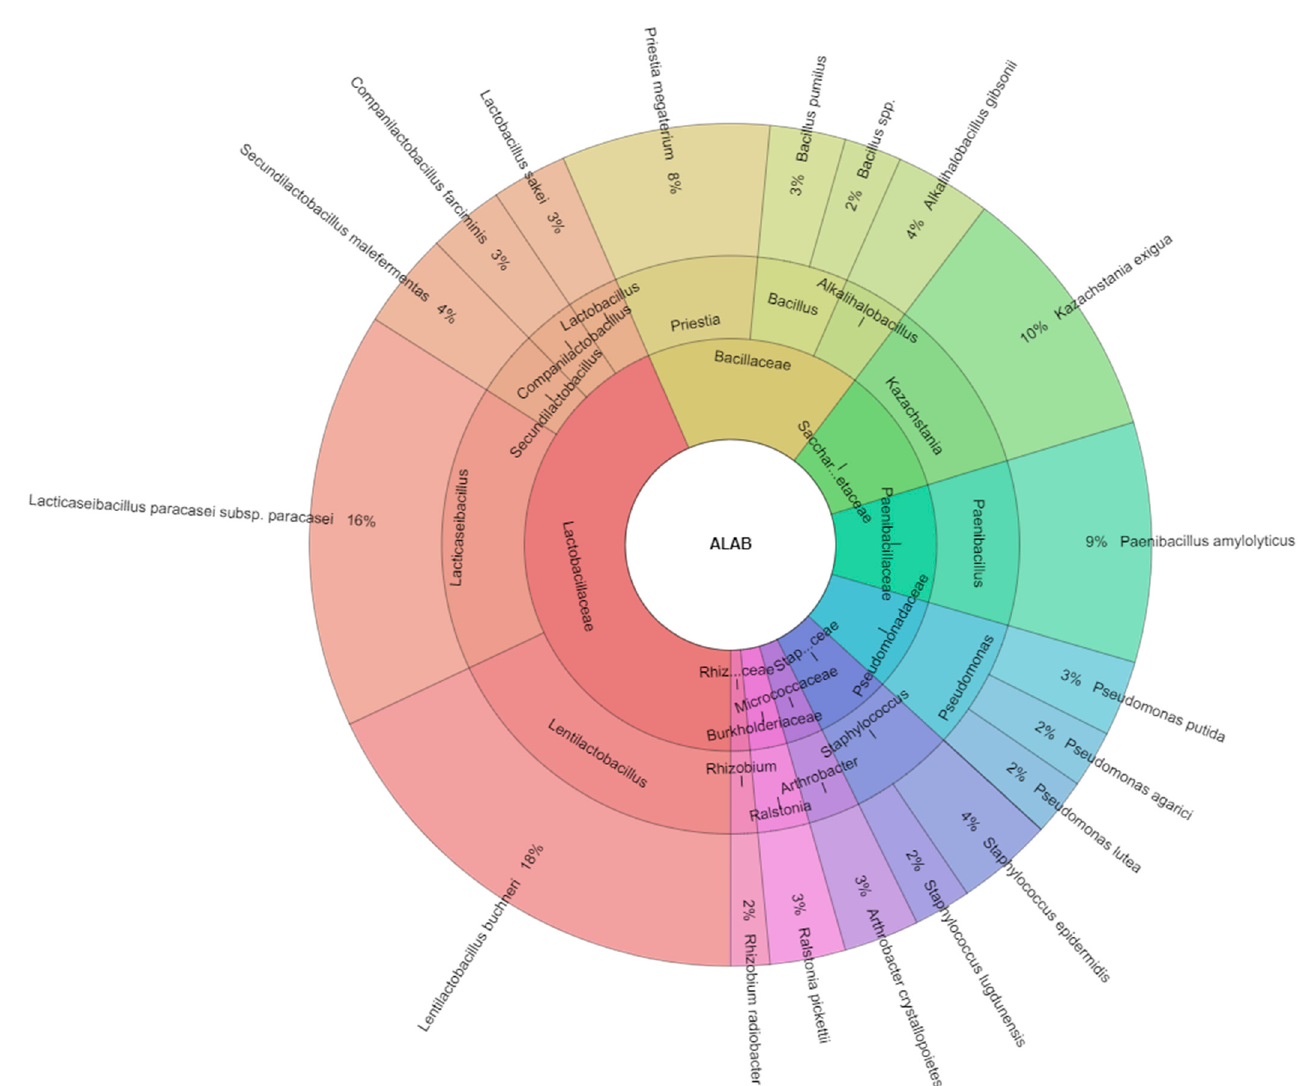
Figure 3. Krona chart of isolated species of bacteria and yeasts from samples of corn silage with additive on the base of lactic acid bacteria.